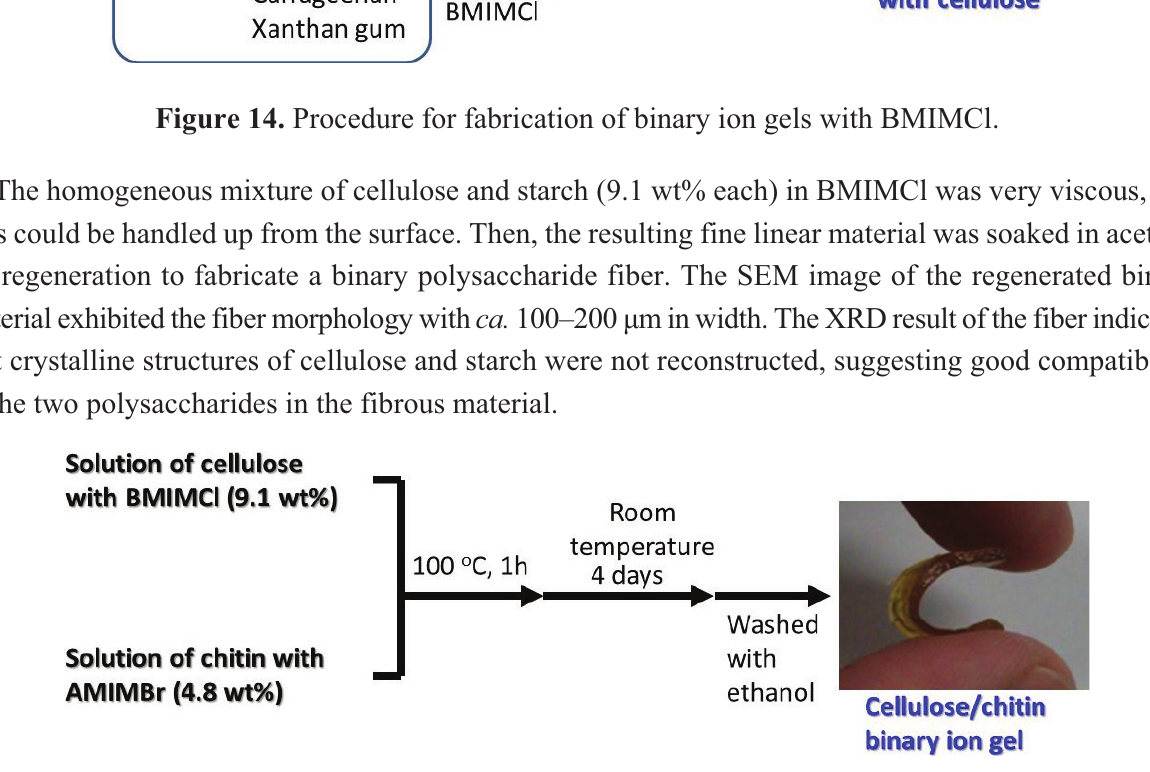
Figure 15. Procedure for fabrication of cellulose/chitin binary ion gel with ILs, BMIMCl and